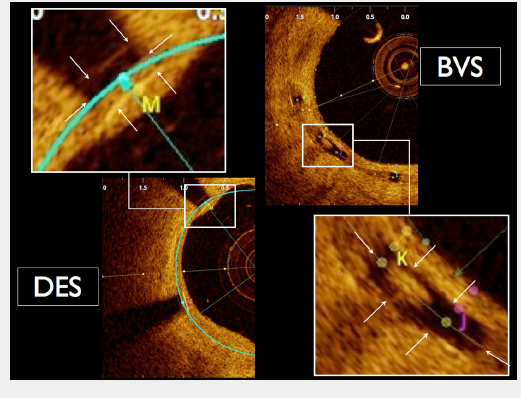
Representative images of OCT analysis of BVS and DES. This image shows the analysis of stent/scaffold area. After identifying all struts in a cross-section, stent/scaffold area was delineated by a curvilinear interpolation connecting the middle points of the struts at mid-strut depth. BVS = bioresorbable vascular scaffold; DES = drug-eluting